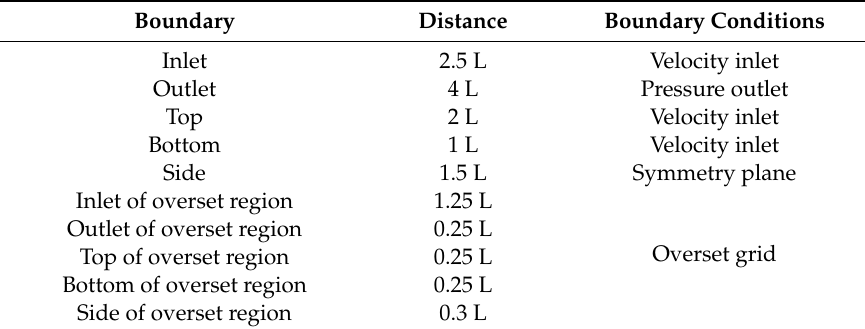
Figure 5. The size of the calculation domains. Table 3. Sizes of the computational